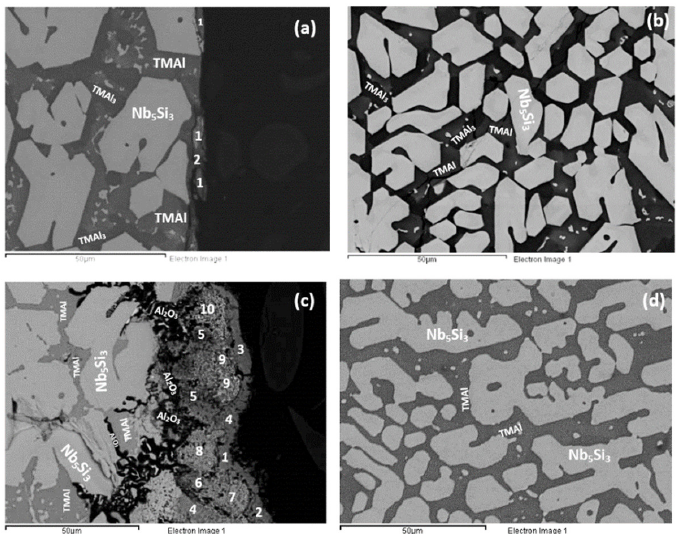
Figure 8. Oxidised specimens of the alloy Nb 1.7 Si 2.4 Ti 2.4 Al 3 Hf 0.5 ( a ) at 800 °C and ( b ) at 1200 °C and weight change versus time data ( c ) at 800 °C and ( d ) at 1200 °C.